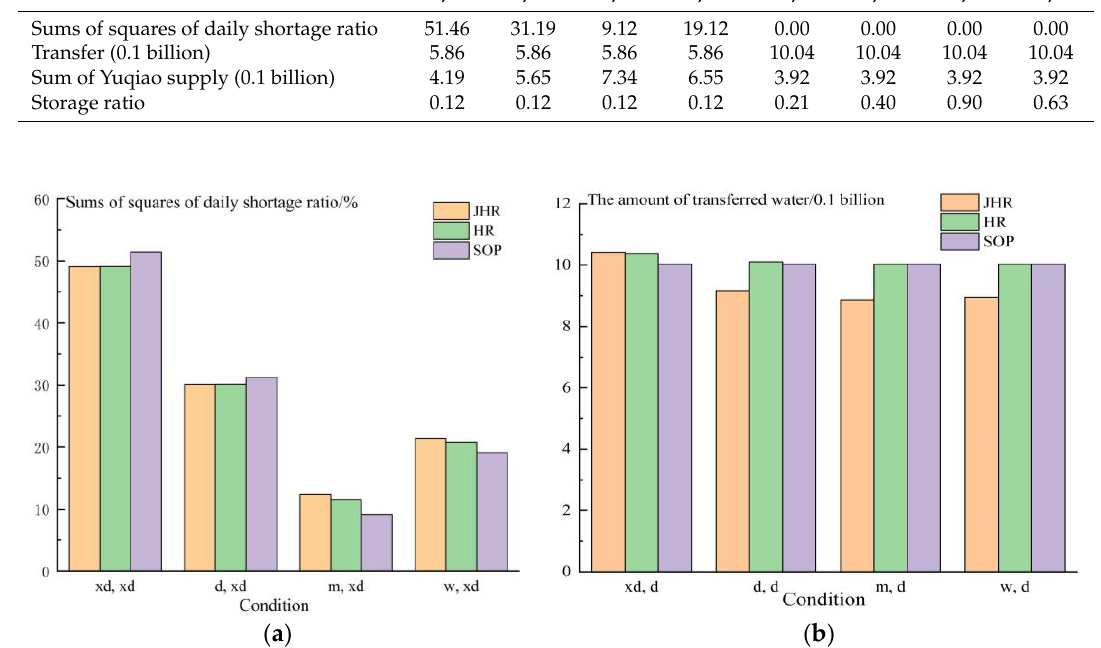
Figure 9. The comparative results based on JHR, HR, and SOP ( a , b show the sums of the squares of